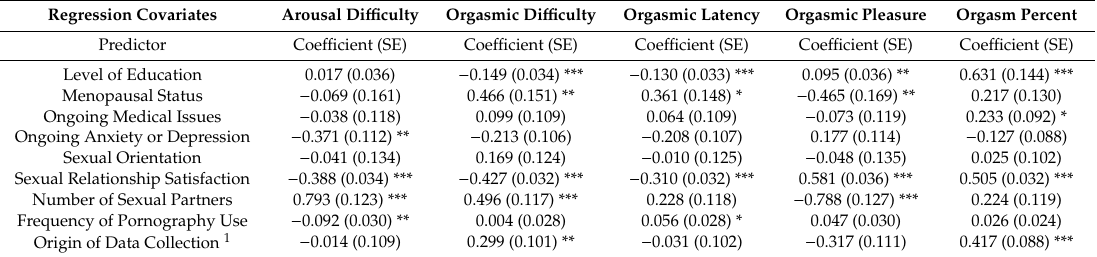
Table 4. Ordered logistic regression results for predicting arousal di ffi culty and orgasmic di ffi culty, latency, and pleasure during partnered sexual activity. Fractional response regression results for predicting the percent of time reaching orgasm during partnered sexual activity.